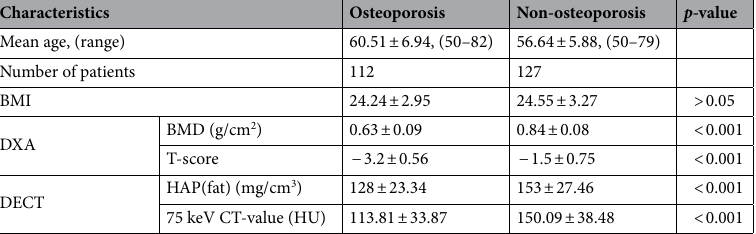
Table 1. Characterization of the patient population in this study. Age was given in years. BMI: body mass index (kg/m 2 ).